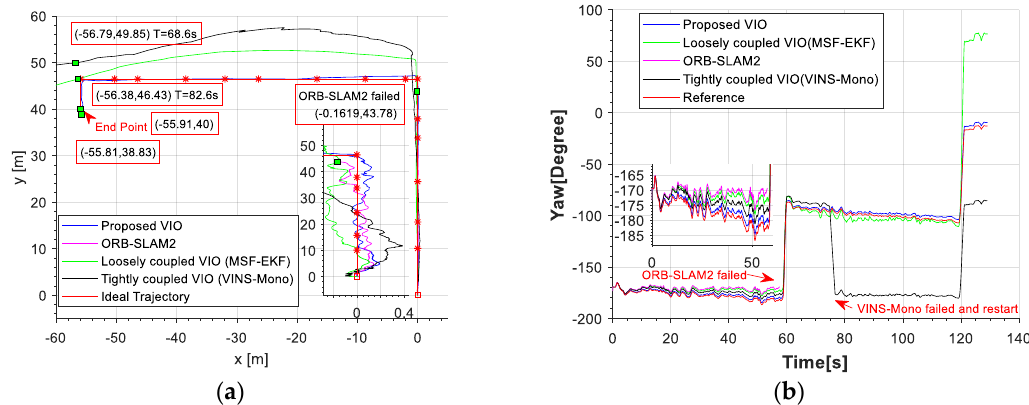
Figure 11. ( a ) An illustration of motion estimation results from different methods. ( b ) An illustration of Yaw angle estimated by different methods. ORB-SLAM2 failed due to few feature points and the noise of MEMS-IMU propagated speedily without measurements. The MEMS-IMU was meeting a corner causing fast angular velocity at 120 s. The noise of the gyroscopes propagated more speedily that causing sudden change in yaw angle difference with MSF-EKF.